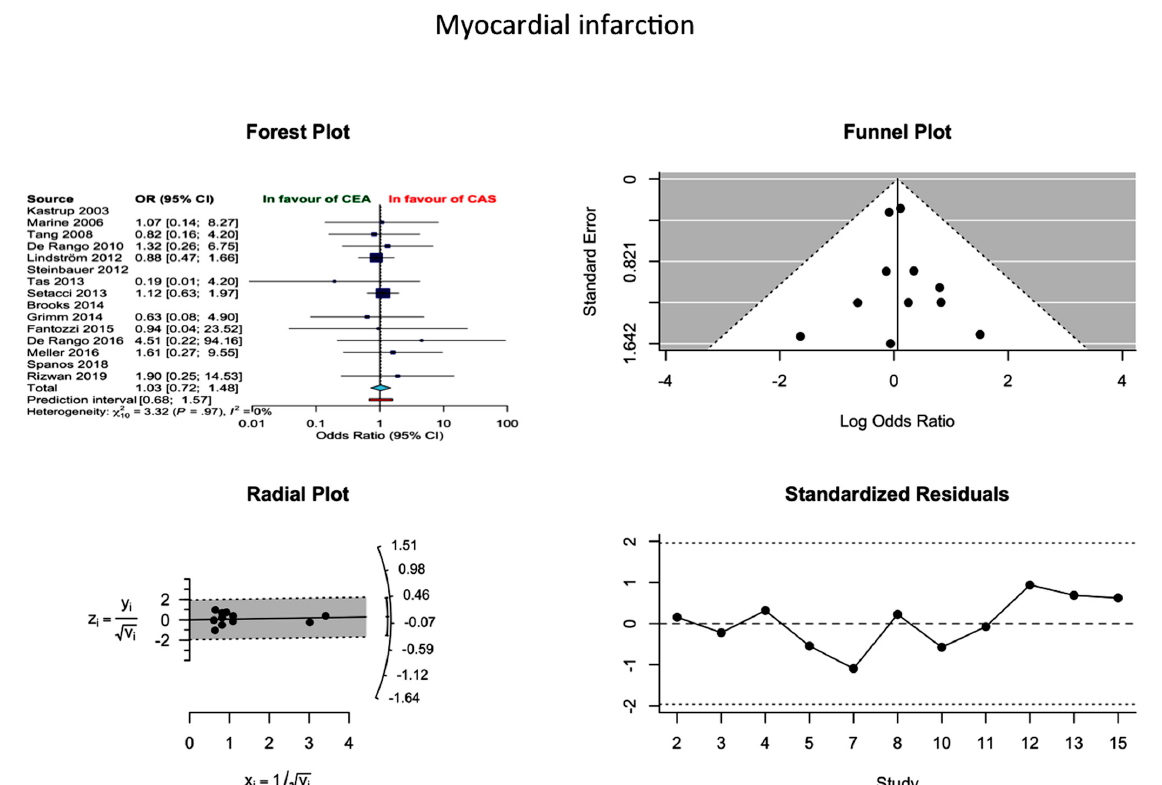
Figure 3. Differences in MI rate and related funnel plot between the CEA and CAS groups [11–25]. Incidence of all events (neurological events/MI/death) was reported in twelve stud- ies, without establishing a statistical difference between the two modalities (OR 1.0 0.82– 1.21, I 2 = 0%). More specifically, the proportion of incidences of all events in CEA and CAS were 3.96 (2.95–5.30) and 4.23 (3.11–5.74), respectively (Figure 4). The probability of pub- lication bias was low.